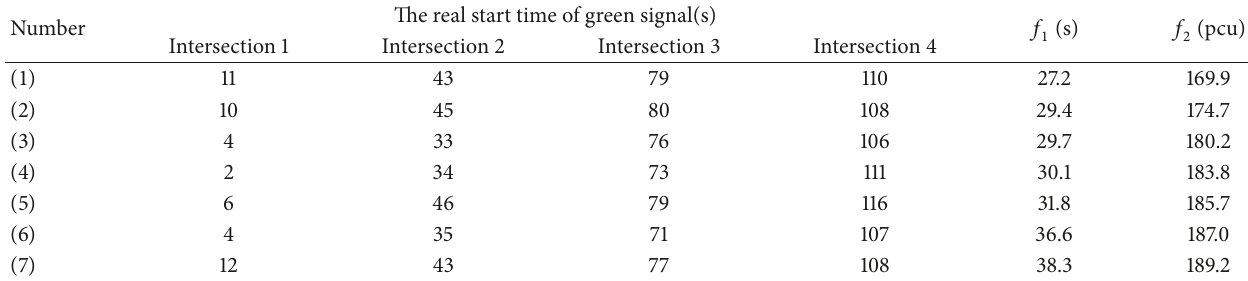
Table 4: The Pareto solution set for an increasing arrival rate when 𝑡 0 is 10 o’clock. The real start time of green